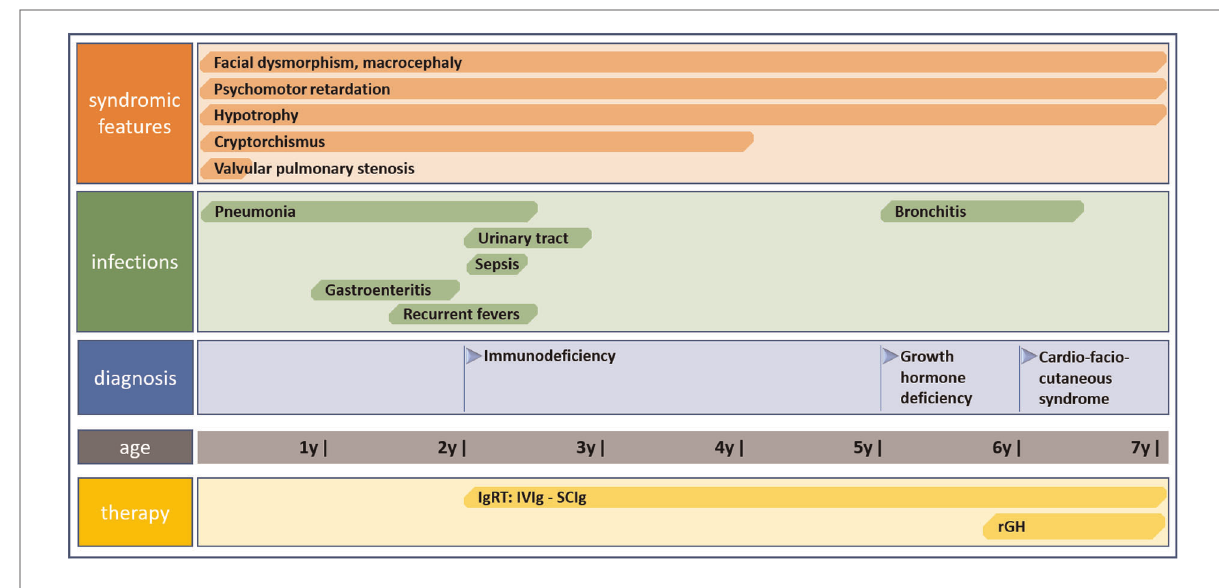
FIGURE 2 Timeline showing clinical case history including symptomatology, infectious history, diagnosis of CFCS, and